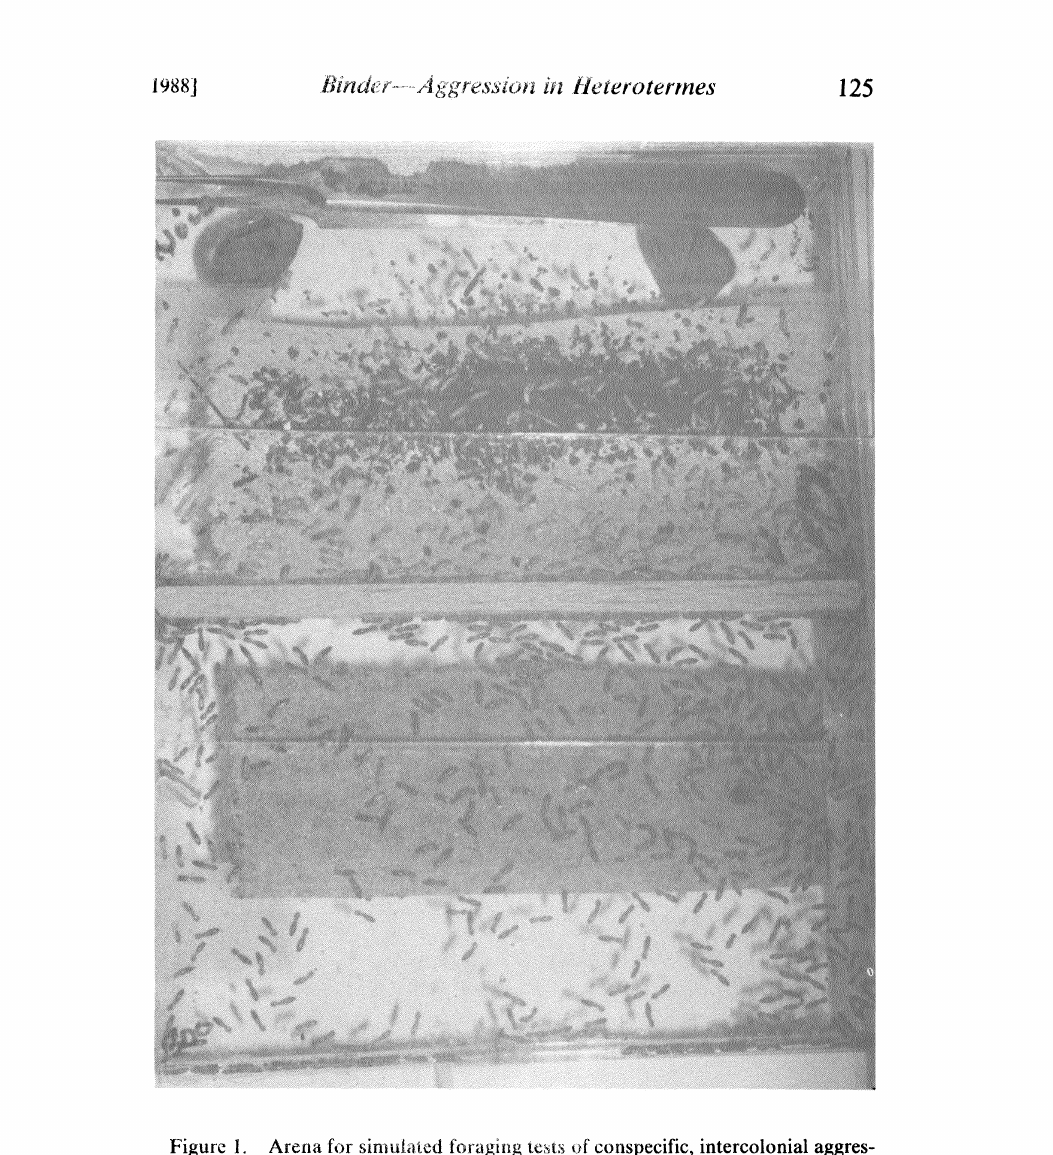
Figure 1, Arena for simu..ated fragig tetzs f conspecific, intercolonial aggres- sion of Heterotermes